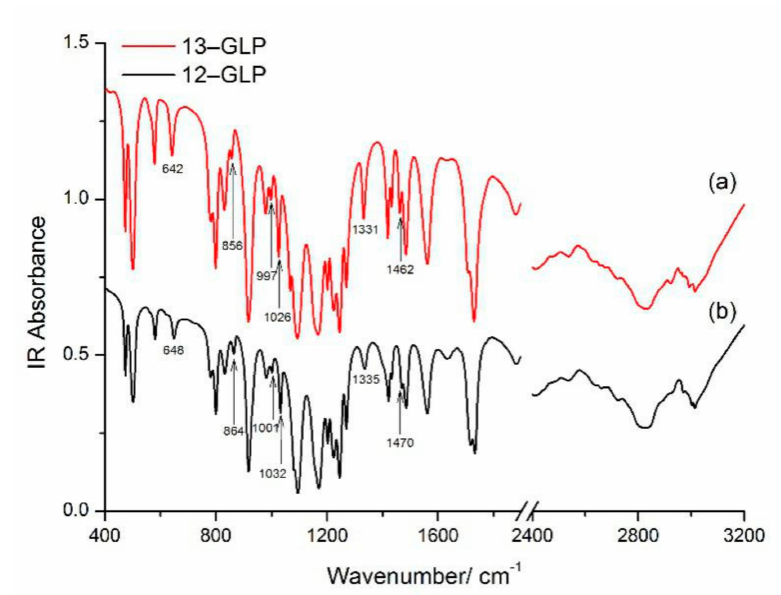
Figure 3. Experimental Fourier transform infrared (FT–IR) spectra of 2- 13 C-glyphosate (13–GLP) and glyphosate (12–GLP) in the spectral region 400 and 4000 cm − 1 ( a ) IR spectra of 13–GLP, ( b ) FT–IR spectra of